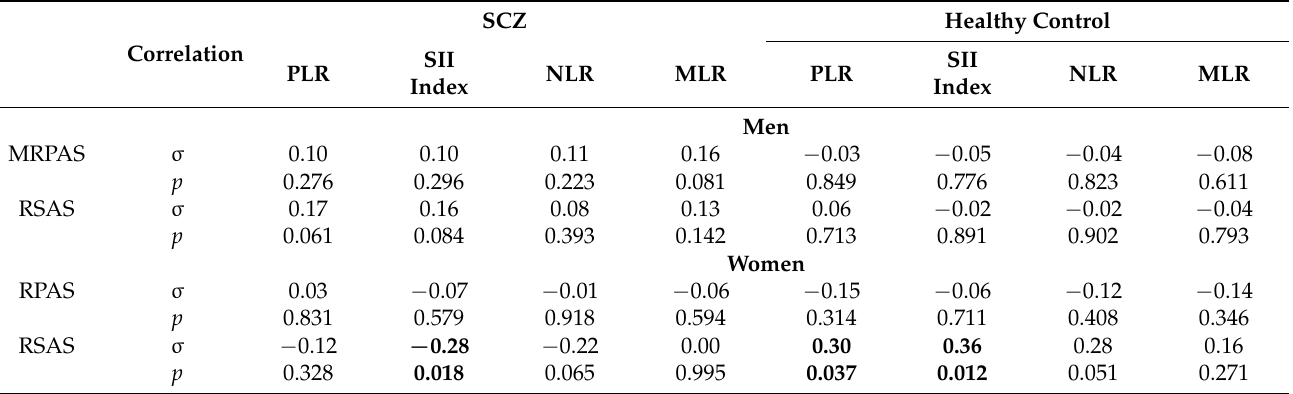
Table 5. Correlation between the severity of social and physical anhedonia and inflammatory ratios in patients with SCZ.